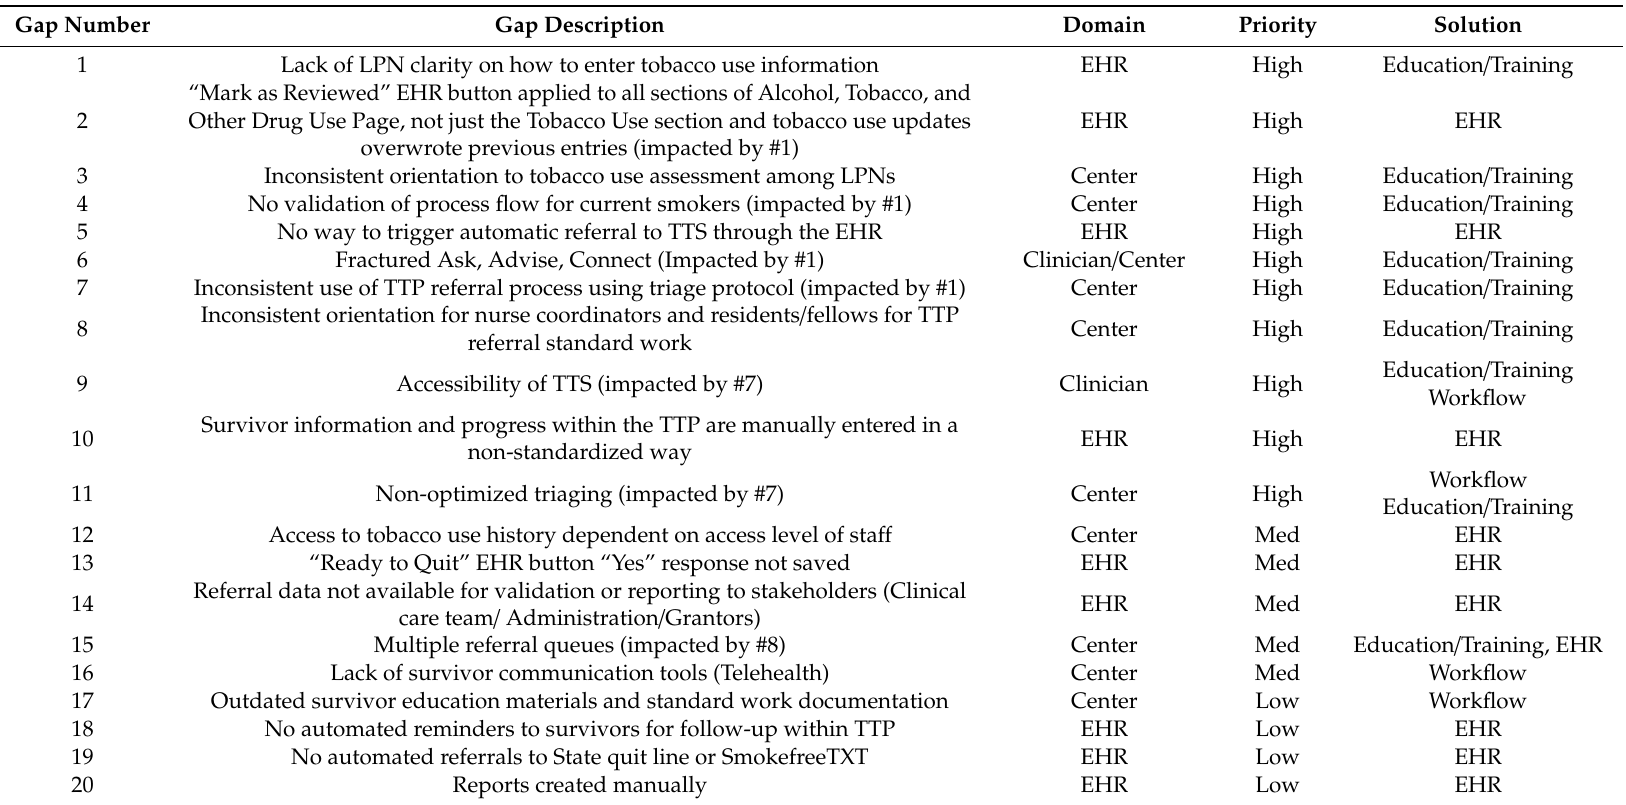
Table 1. Gap Analysis, Prioritization, and Potential